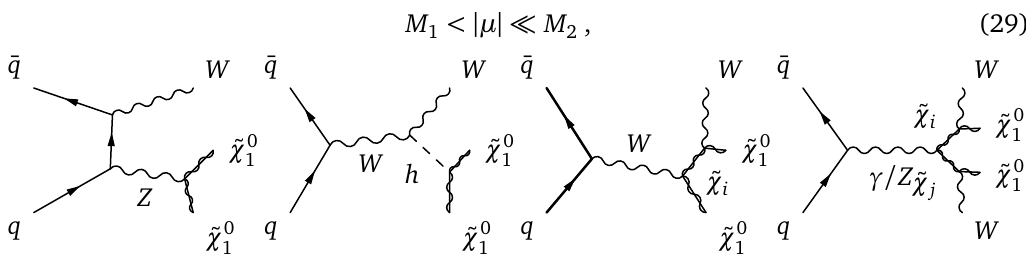
Figure 10: Feynman diagrams contributing to mono- W production in the MSSM, including initial-state W -radiation with a Z -portal, Wh production with a SM-like Higgs portal, chargino decays, and W -pair